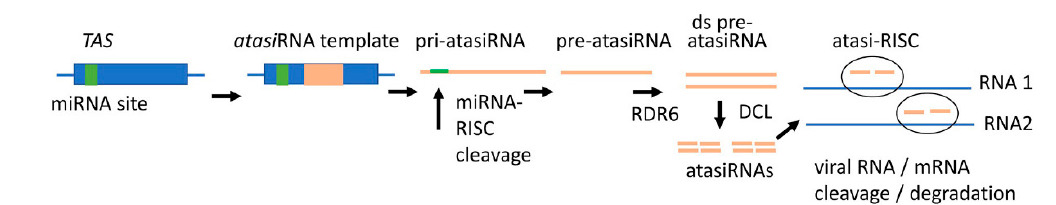
Figure 3. The antiviral atasiRNA pathway. The diagram schematically shows how atasiRNA silencing construct can be generated by replacing a known tasiRNA sequence in a TAS gene with a sequence containing four different atasiRNA fragments targeting multiple sites in two different viral or host RNAs. Like all natural TAS transcripts, transcripts generated from the modified TAS genes (pri-atasiRNAs) contain a miRNA targeting site which is required for processing pri-atasiRNAs into pre-tasiRNAs. After an initial cleavage at this site triggered by miRNA, RDR6 converts the obtained transcripts into ds pre-atasiRNA fragments which are consequently processed by DCL to generate siRNAs that target viral or host RNAs. (D)’s pre-atasi RNAs can be potentially applied exogenously.